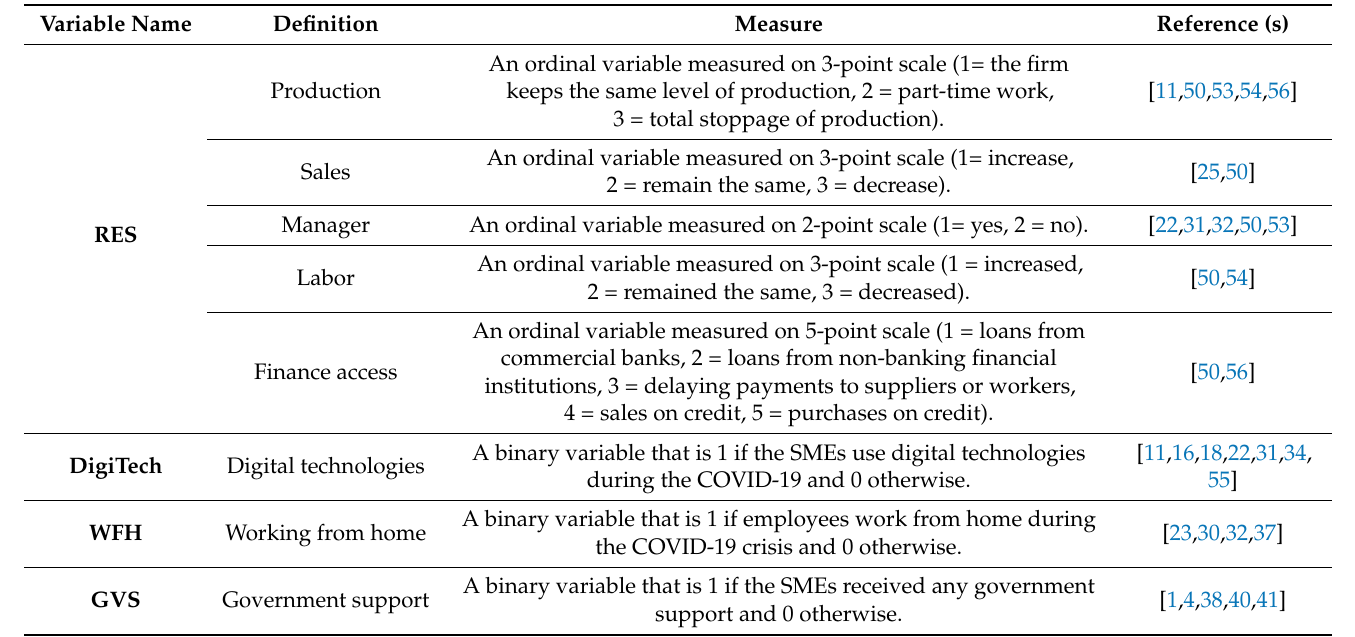
Table 2. Description of used